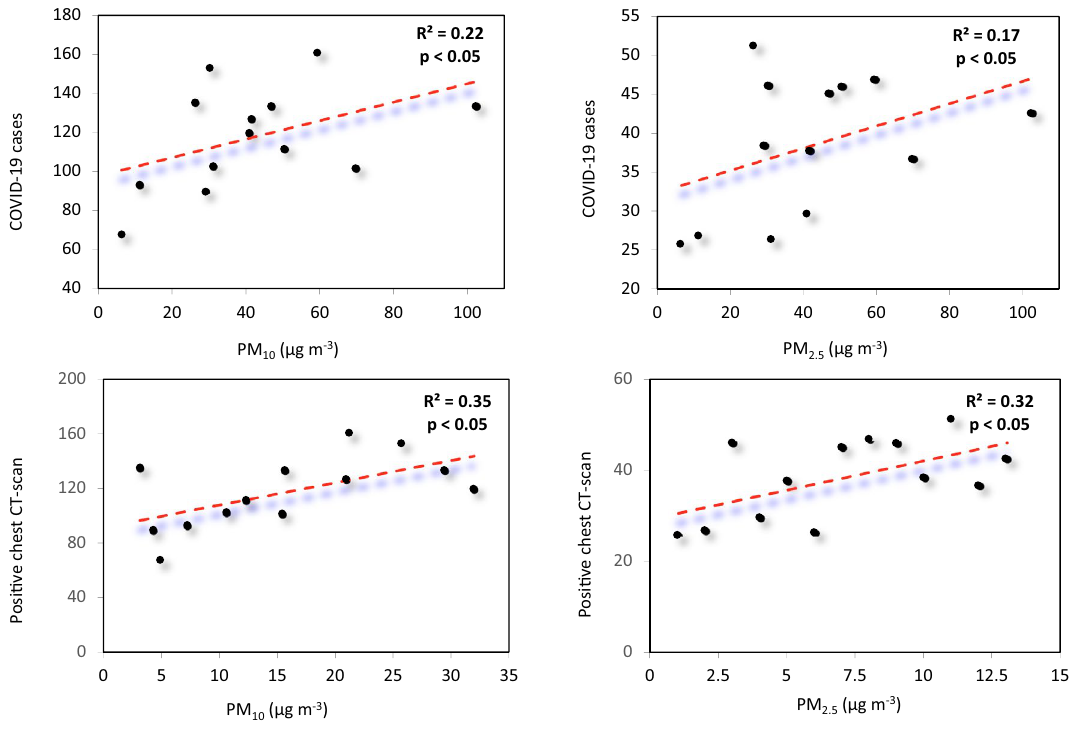
10 and a' PM 2.5 , and b , b'